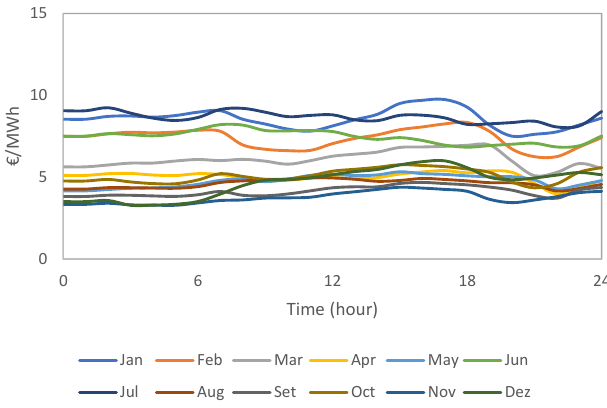
Figure A8. Average daily CO 2 prices for electricity consumed, per